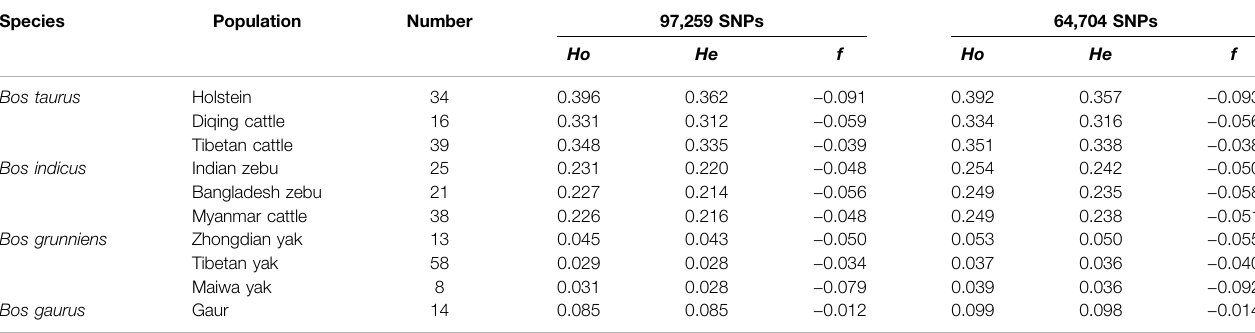
TABLE 2 | Genetic diversity index among Bos